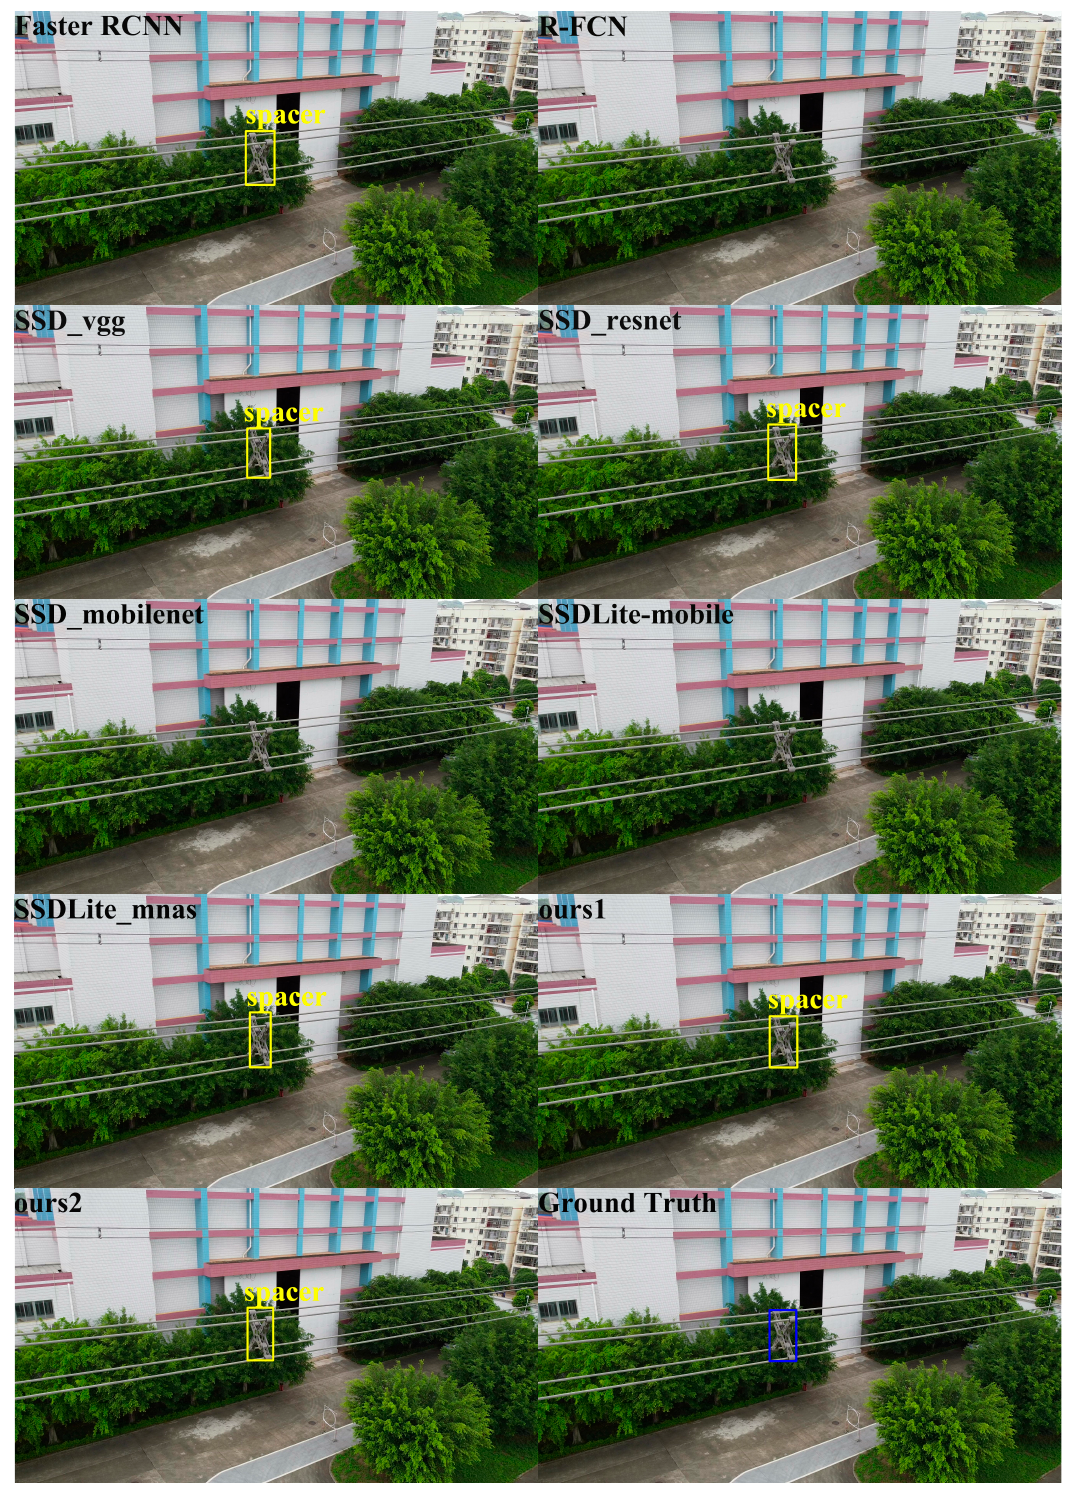
Figure 11. Spacer detection results. The blue box is the ground truth of the position of spacer in the image.